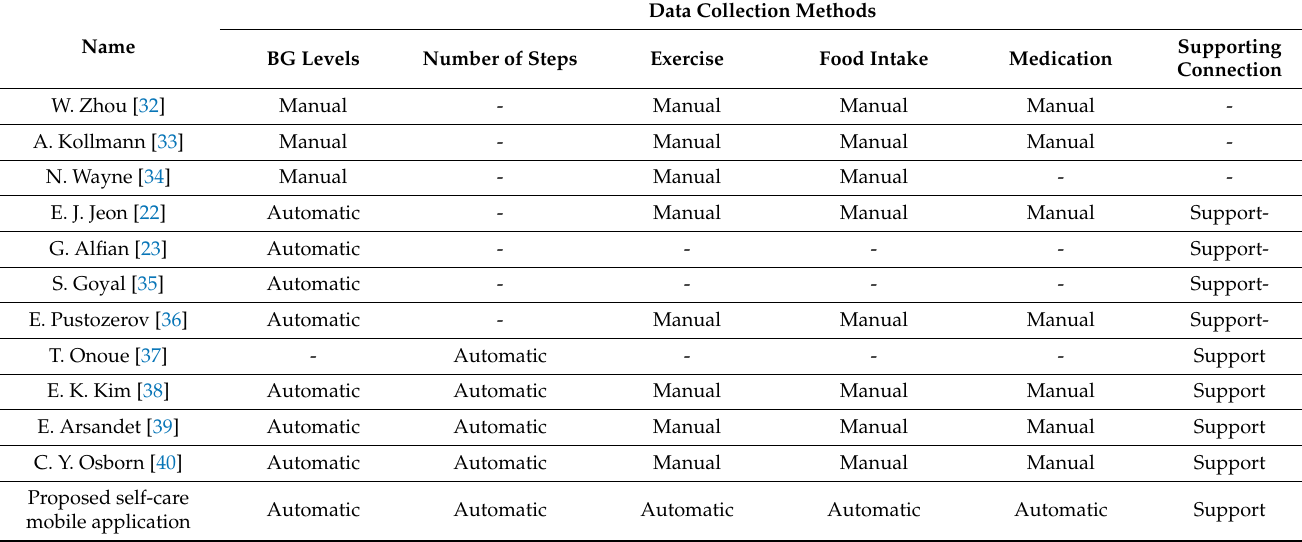
Table 8. Comparison of the proposed self-care mobile application and other